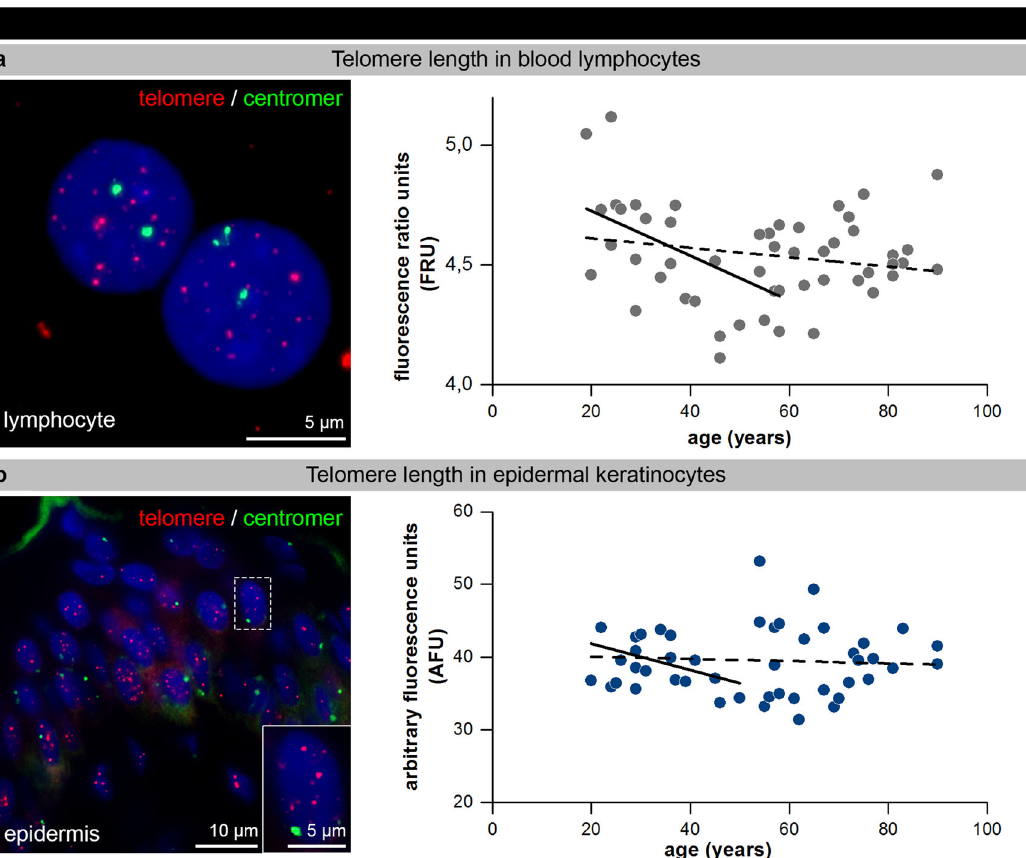
Fig. 3 Telomere-length heterogeneity in blood lymphocytes and epidermal keratinocytes. a IF micrographs of telomere (hybridized with telomere-speci fi c PNA probe, red) and centromere 2 (green) FISH staining in human blood lymphocytes (left panel). Graphic presentation of relative telomere-length measurements in blood lymphocytes of donors of varying age ( n = 51) are given as fl uorescence ratio units (FRU). Solid trend line indicates age-dependent relative telomere-length reduction up to 60 years. b IF micrographs of telomere (red) and centromere 2 (green) staining in human epidermal keratinocytes (left panel) of tissue sections. Graphic presentation of the mean relative telomere length as arbitrary fl uorescence units per nucleus (AFU) in epidermal keratinocytes of donors of varying age ( n = 51). Solid trend line indicates an age-dependent telomere-length reduction up to 50